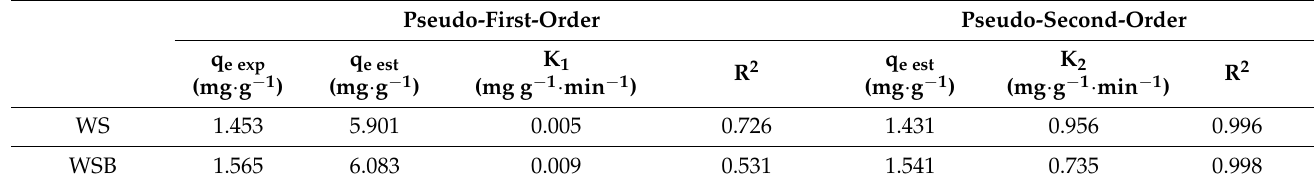
Figure 3. Kinetic models of metribuzin adsorption. Table 2. Kinetic model parameters for metribuzin and WS/WSB